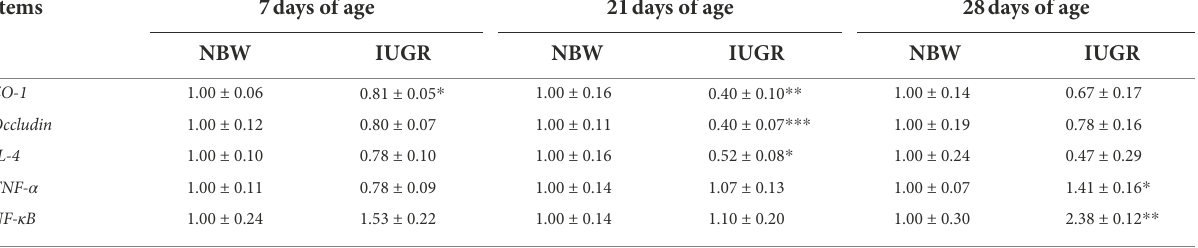
Data are presented as means ± SEM ( n = 8). IUGR, intrauterine growth restriction; NBW, normal birth weight; ZO, zonula occludens; IL, interleukin; TNF- α , tumor necrosis factor alpha; NF- κ B, nucelar factor kappa